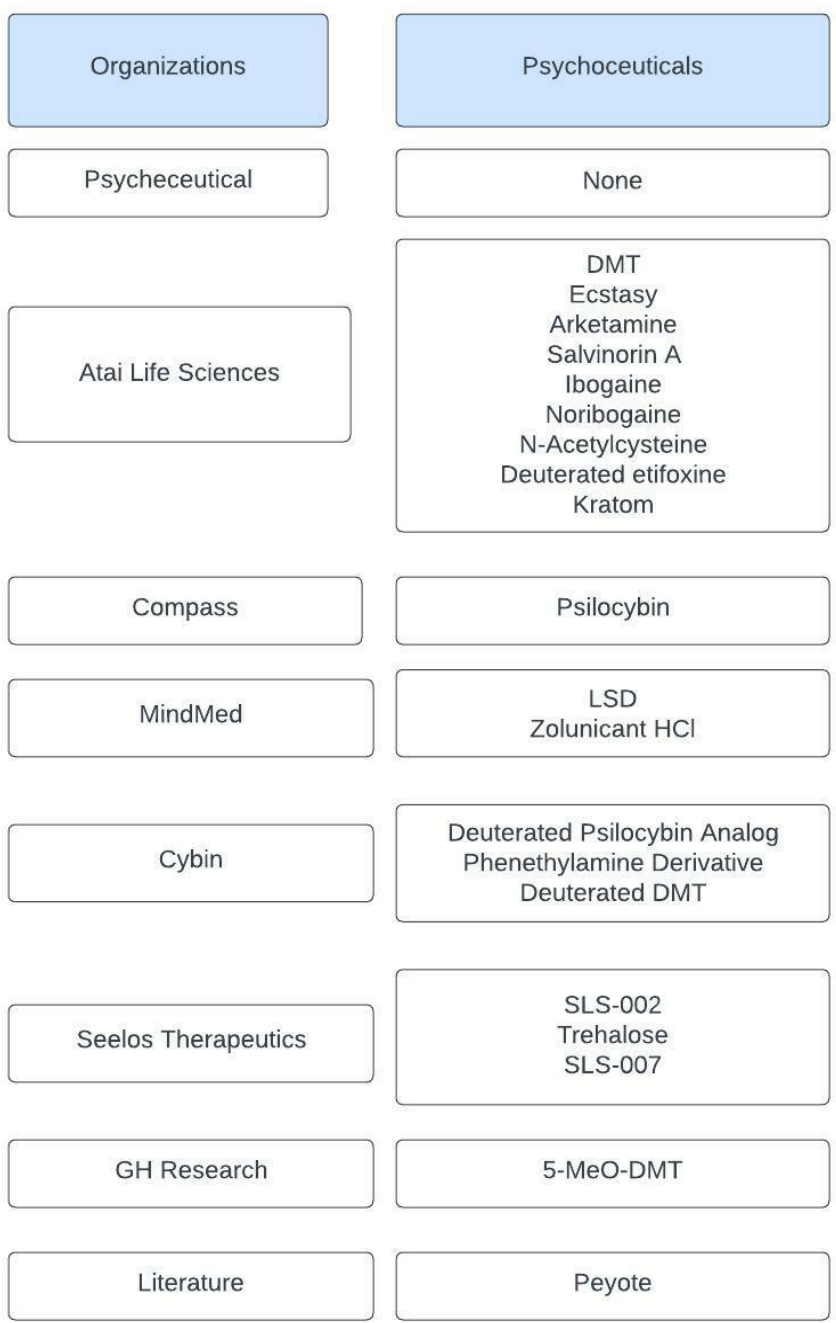
Figure 2. Psychoceuticals selected and their sources.